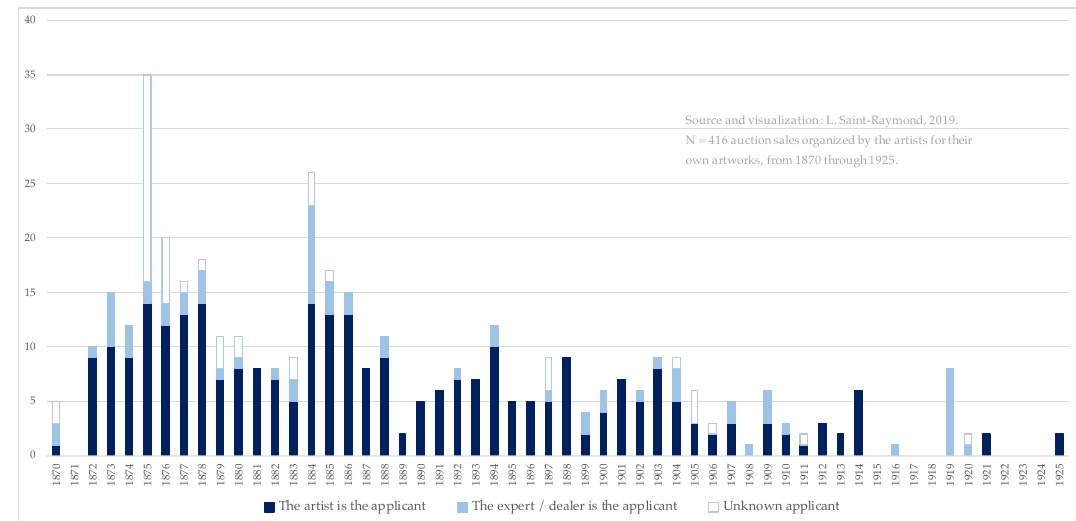
Figure 4. Number of auction sales organized by the artists themselves for their own works, depending on the identity of the applicant, from 1870 through 1925. (Used by